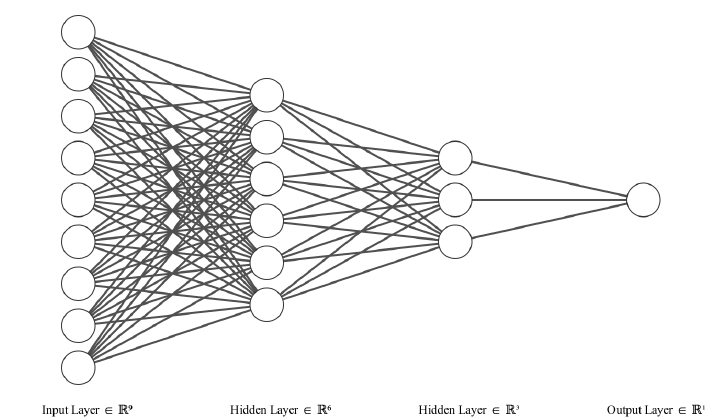
Figure 9. Basic Neural Network Structure.